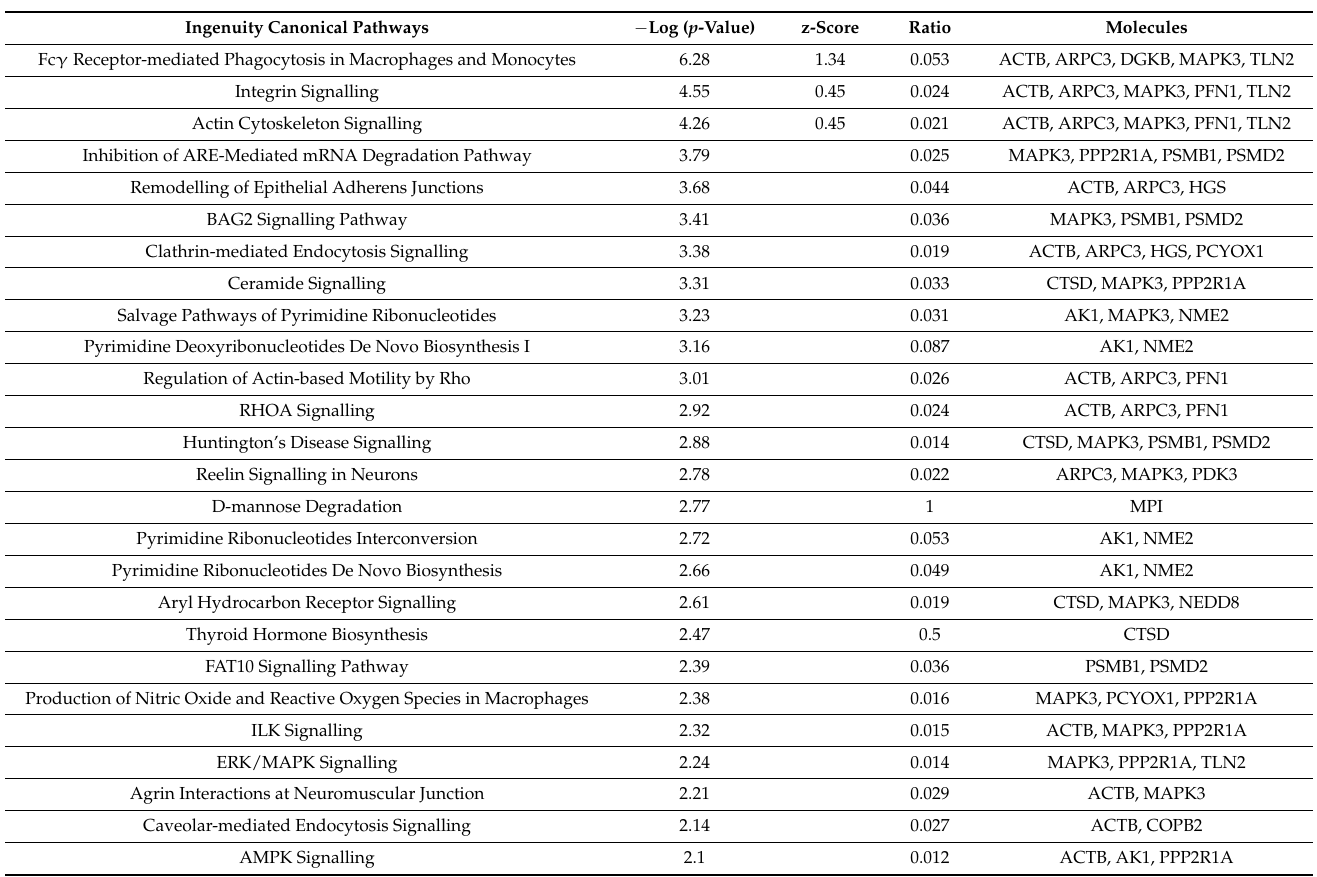
Figure 4. Actin signalling and phagocytosis are upregulated in post-hypoxia recovery. ( A ) A volcano plot visualisation of proteomic changes shows dramatically altered expression of targets implicated in synapse formation (Adgrl1) and potassium channel tetramerization (Kctd4), with endosomal trafficking (Hgs) and mitochondrial respiration (Uqcrh) amongst the most significant hits. ( B ) Ingenuity network enrichment analysis ( p = 1.00 × 10 − 52 ) highlights actin as a highly upregulated central node (Actin, ACTB), in addition to upregulation of the BCR complex in antigen presentation and phagocytosis. Table 1. Ingenuity canonical pathways post-hypoxia. Ingenuity pathway analysis, ranked by -log ( p -value) highlights actin upregulation amongst the most significant changes ( p = 5.3 × 10 − 5 , z = 0.4), in addition to phagocytosis signalling ( p = 5.2 × 10 − 7 , z = 1.3), compared to normoxia-treated